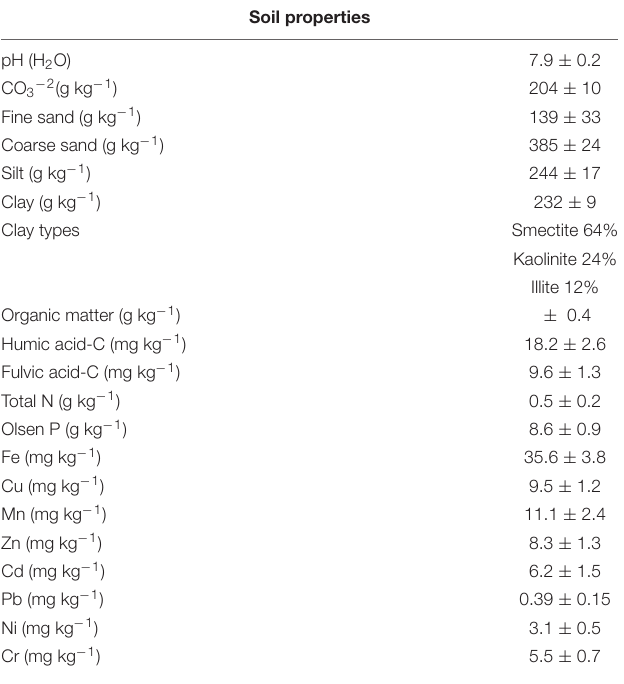
TABLE 1 | Soil properties (mean ± standard